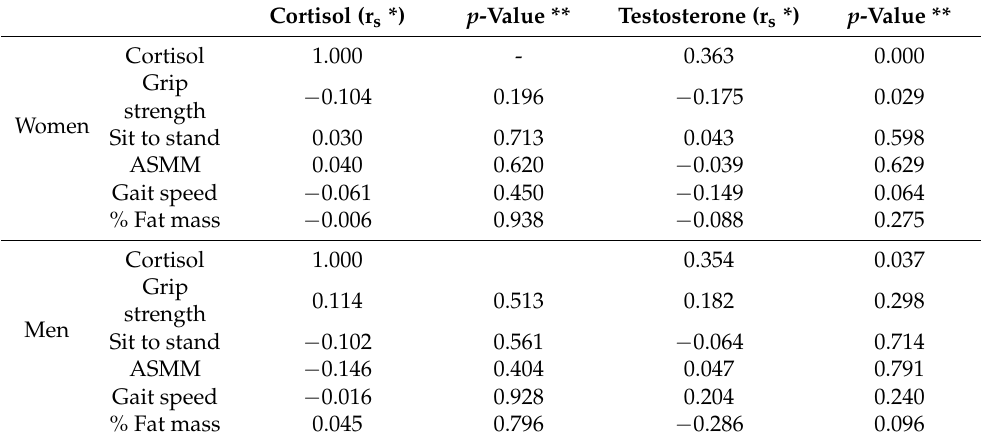
Table 6. Relationship between sarcopenia and sarcopenic obesity variables and salivary biomarkers.